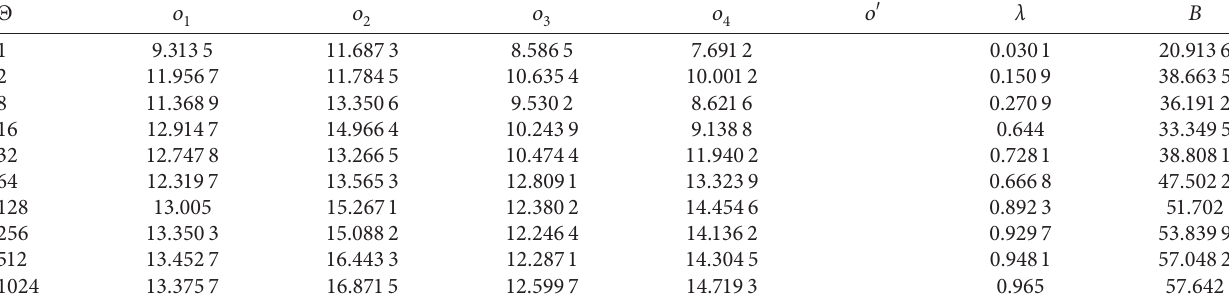
Table 3: Result of model